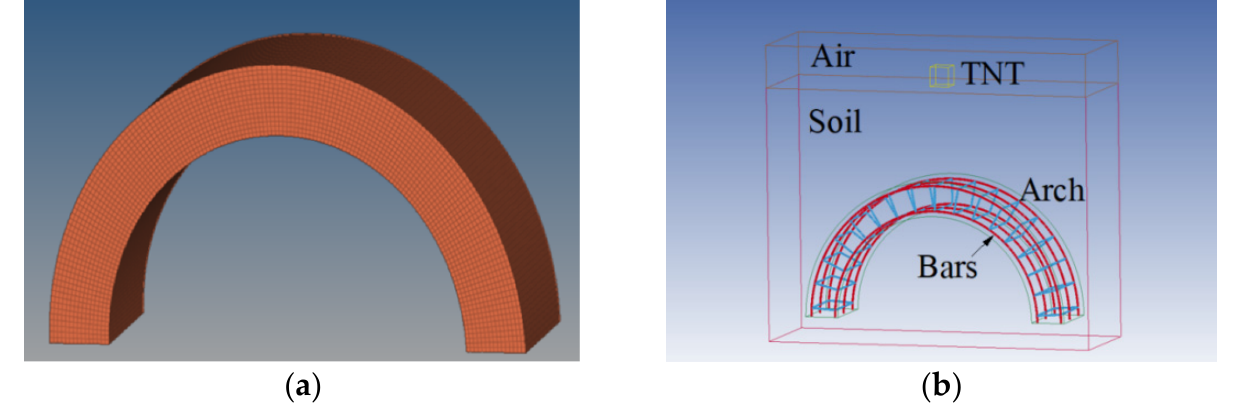
Figure 2. The meshing of ( a ) concrete arch structure, and ( b ) BFRP bars.